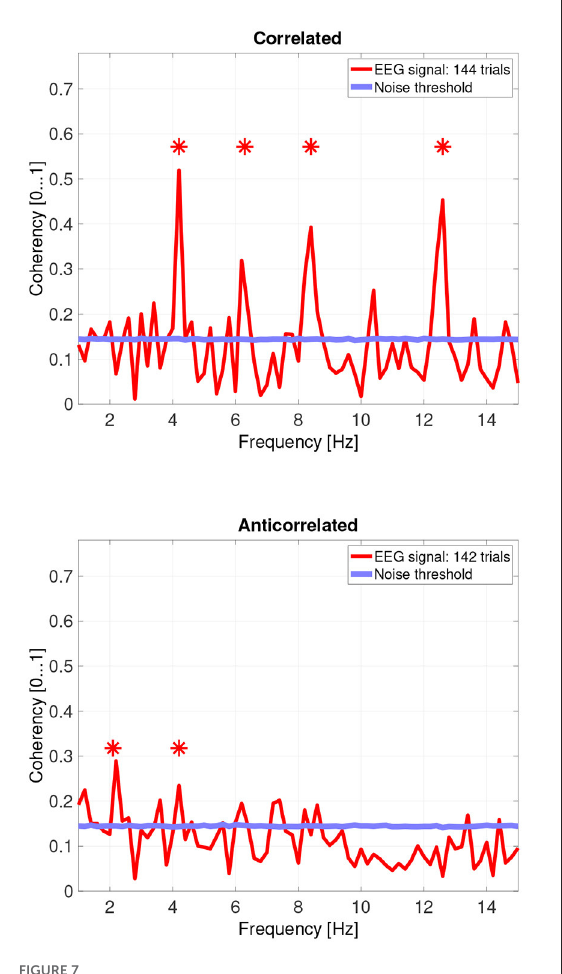
FIGURE7 Coherency values from participant LN. The stars above the peaks indicate successful detection of the harmonic of the stimulus frequency. Note that the coherency plots are in phase space, and that they are not showing spectrum: a higher coherency value imply a stronger relationship to the stimulus. The “Noise threshold” is created with 10,000 data sets having the same number of trials, with the trials containing only white noise. The line shows the 95 th percentile of the coherency values created from these synthetic data